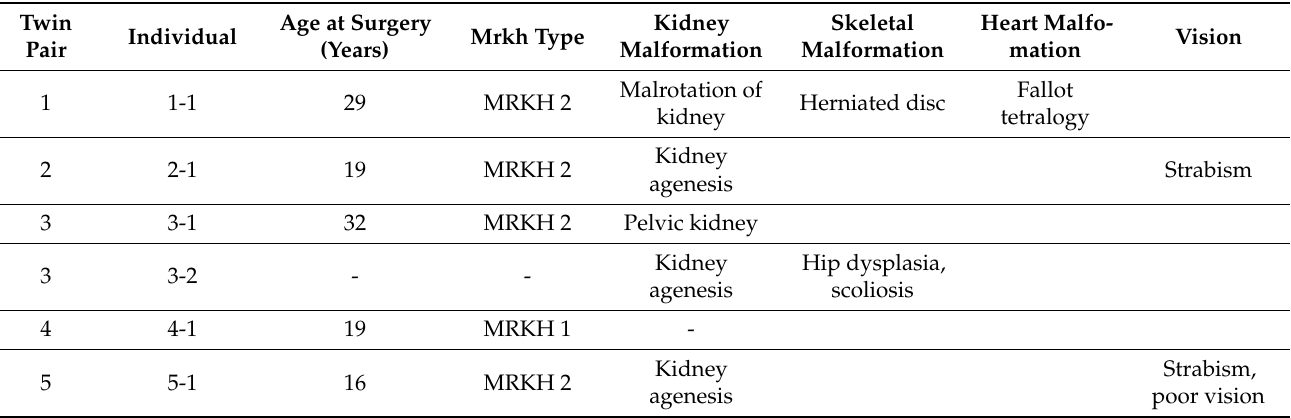
Table 1. Phenotype of individuals in this